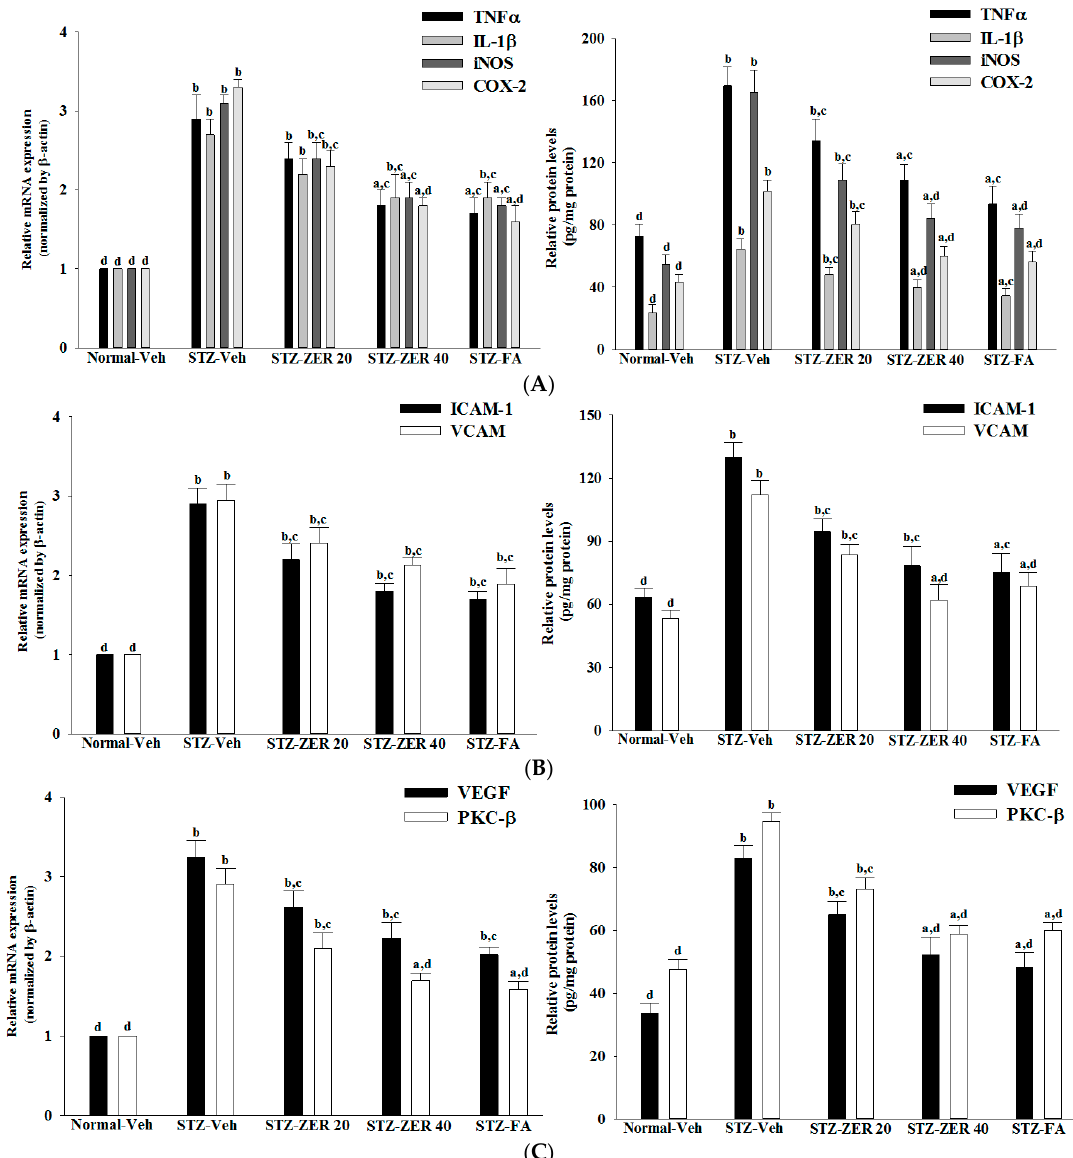
Figure 5. Effects on mRNA (left pannels) and protein expression (right pannels) of inflammatory cytokines ( A ), chemokines ( B ) and angiogenic parameters ( C ). STZ-diabetic rats were administered 20 mg/kg/day zerumbone (STZ-ZER 20), 40 mg/kg/day zerumbone (STZ-ZER 40) or 100 mg/kg fenofibric acid (STZ-FA) by oral gavage once daily for three months. Another group of STZ-diabetic rats (STZ-Veh) and normal rats (Normal-Veh) were administered the same volume. Data are mean ± SD from eight rats per group, and the experiments were repeated independently at least three times with similar results. a p < 0.05 and b p < 0.01 compared to vehicle-treated normal rats, respectively; c p < 0.05 and d p < 0.01 compared to the values of vehicle-treated STZ-diabetic rats, respectively.